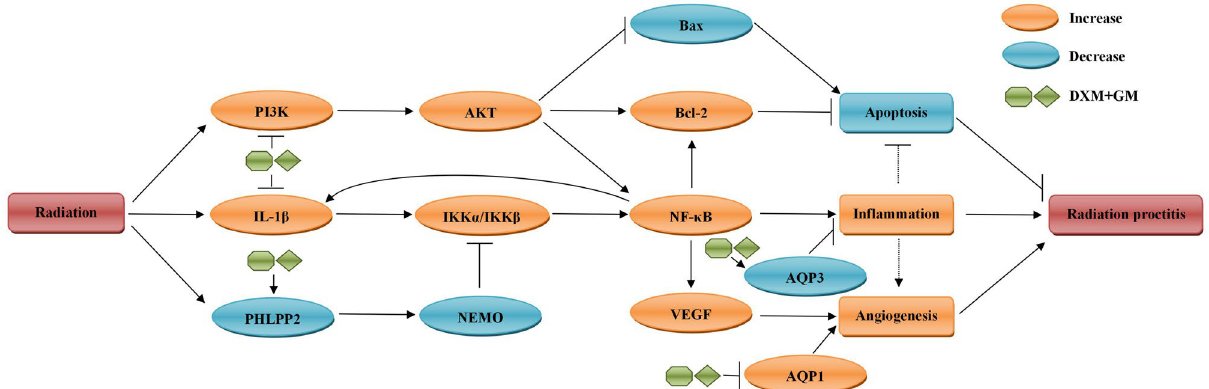
Figure 10. Novel mechanisms underlying inhibition of inflammation-induced angiogenesis by DXM + GM enema via PI3K/AKT/NF-κB/VEGF pathways in ARP mice. Radiation stimulates PI3K/AKT signaling